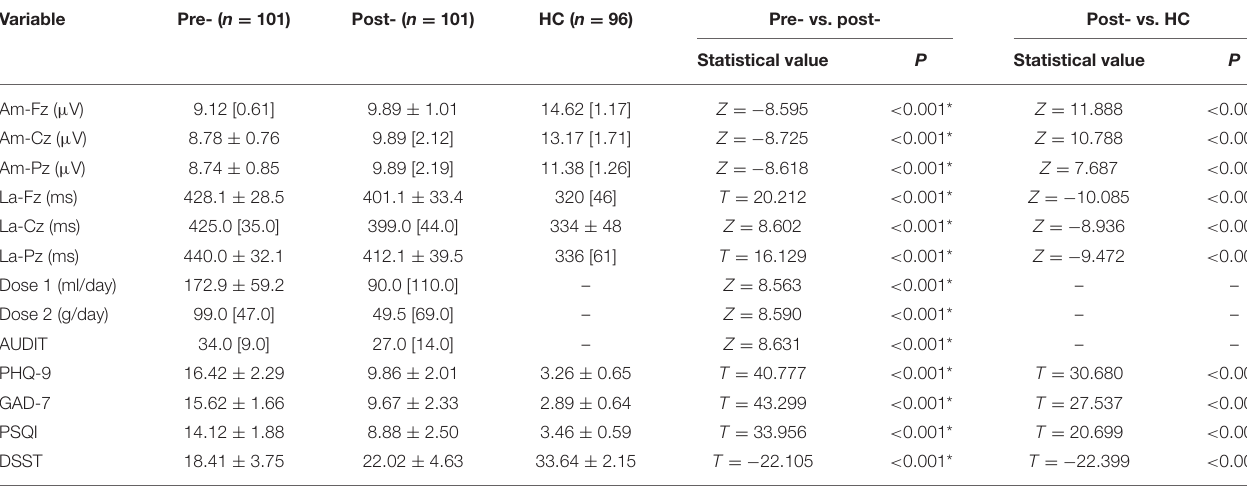
TABLE 5 | Change of outcome measures after 8 weeks pharmacotherapy intervention ( n = 101) and comparison between the post-intervention AUD group ( n = 101) and healthy controls (HC) ( n = 96).